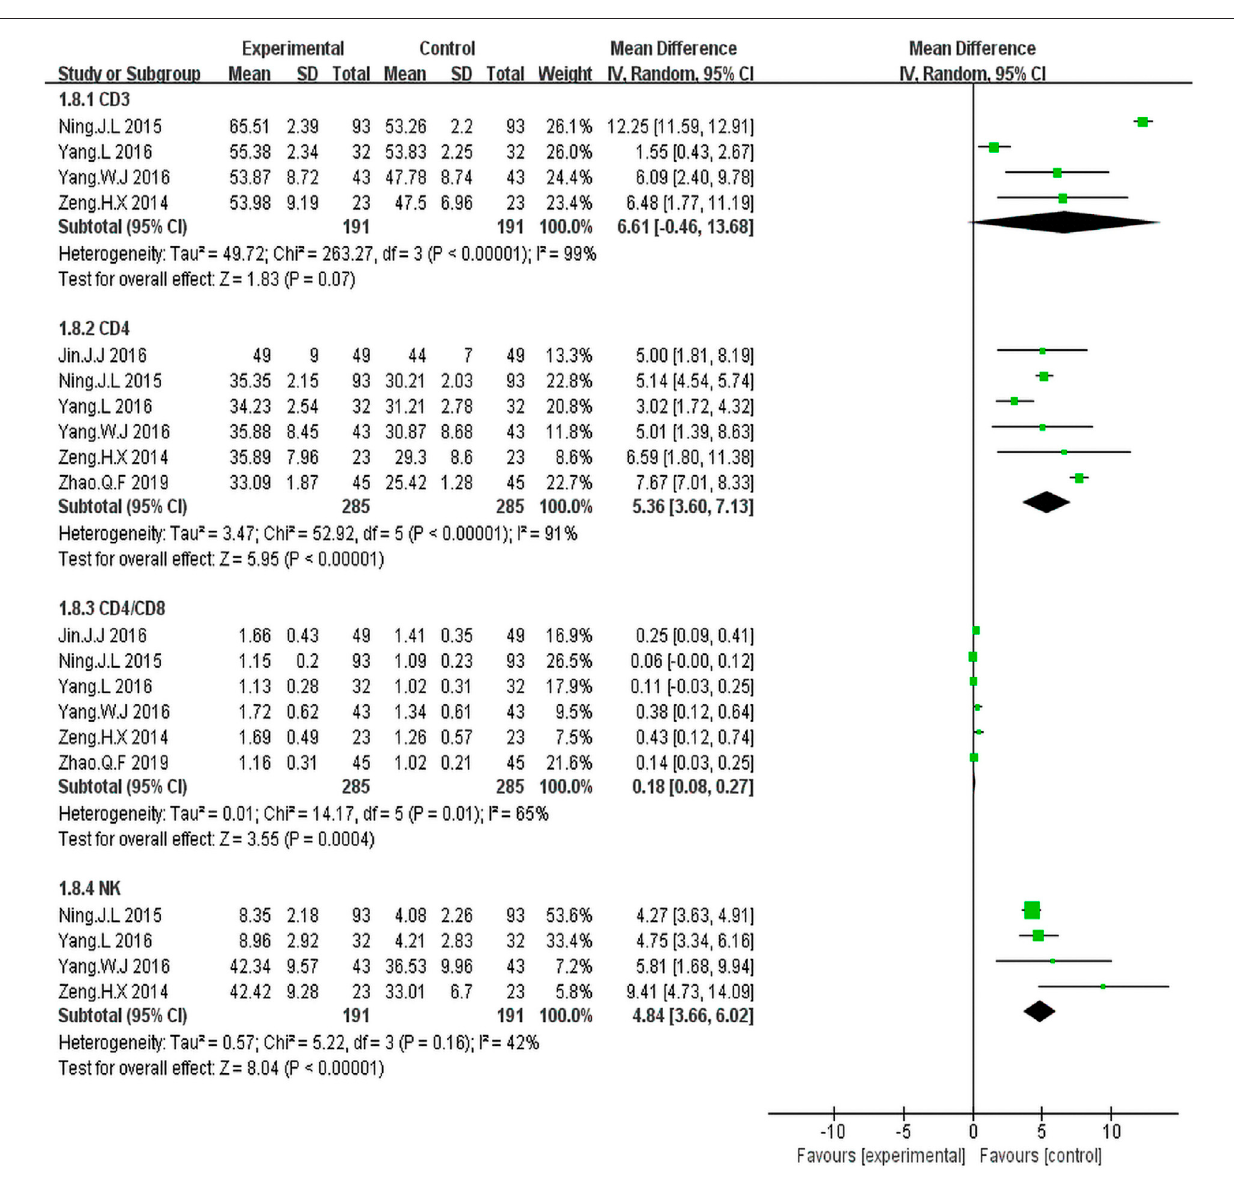
Frontiers in Pharmacology |